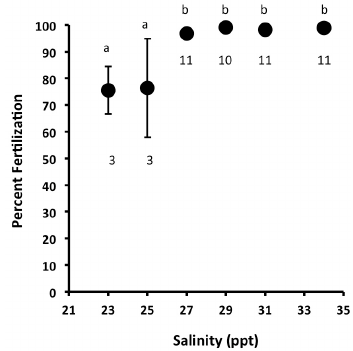
Figure 1. Fertilization percentage of A. cf. solaris eggs across a range of salinities (ppt). Circles represent the mean (±SE) percent fertilization of 3–11 independent, replicate crosses for each salinity treatment. Numbers beneath each data point indicate the number of replicate females for that point. Letters above each data point indicate significant differences in percent fertilization among salinities based on a Kruskal-Wallis H test and post-hoc tests (see text for details). For symbols where error bars are not visible, the error bars are contained within that symbol. Salinity had a significant effect on the proportion of embryos that exhibited normal development. Using a mixed-model ANOVA, we found that the proportion of embryos exhibiting normal development was significantly reduced when salinity was reduced ( F 1,4 = 9.989; p < 0.001;